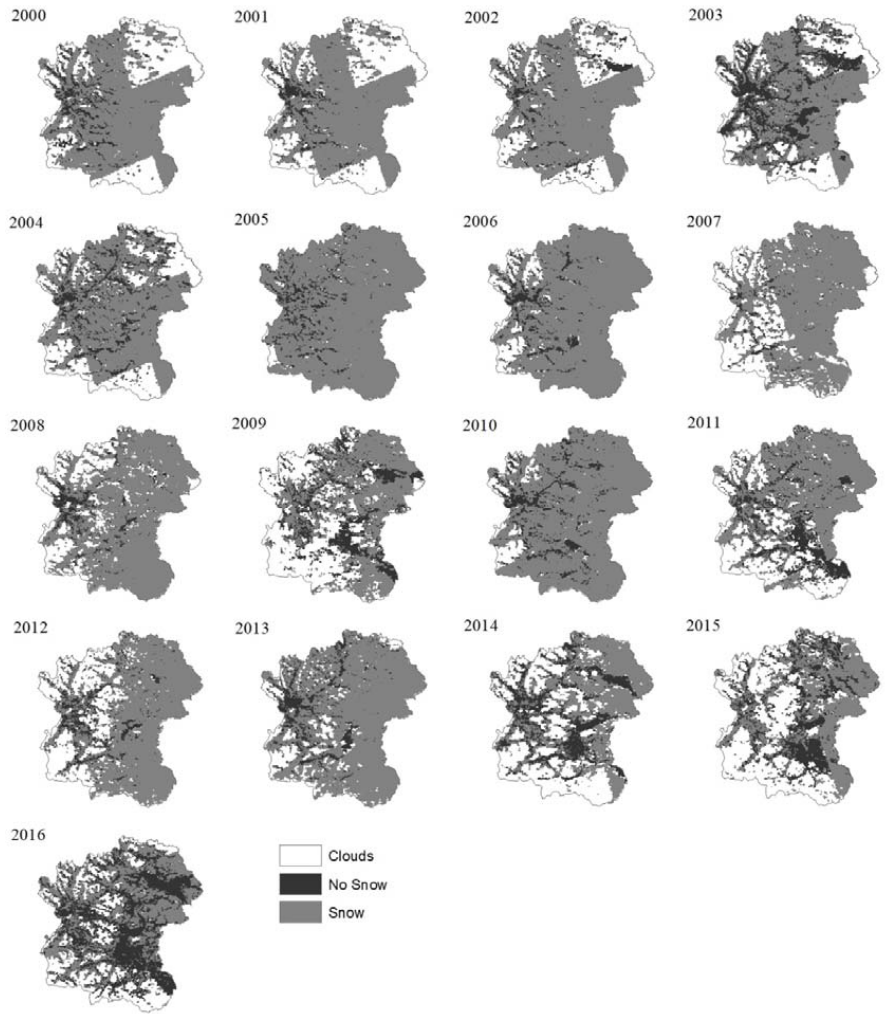
Figure 4. Annual maximum SCA for the 2000–2016 period.